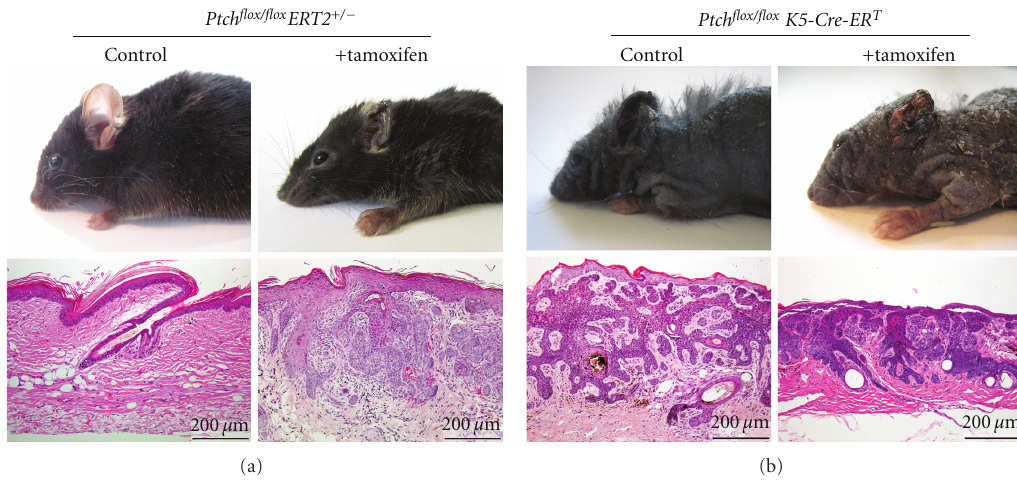
Figure 1: Features of BCC in Ptch flox/flox ERT 2 + / − and Ptch flox/flox K 5- Cre - ER T mice. Ptch flox/flox animals were bred with the mouse lines ERT2 or K 5- Cre - ER T . The respective Ptch flox/ + ERT 2 + / − and Ptch flox/ + K 5- Cre - ER T mice were backcrossed to Ptch flox/flox mice to obtain Ptch flox/flox ERT 2 + / − and Ptch flox/flox K 5- Cre - ER T mice. ERT2 or K 5- Cre - ER T was activated by one intramuscular (i.m.) injection of 100 μ g tamoxifen as described recently [20, 85], or by intraperitoneal injections of 1 mg tamoxifen (10 μ g/ μ L in sterile ethanol/sun flower oil 1: 25) for 5 consecutive days (see [88]), respectively. Genotyping of the Ptch flox , Ptch del , ERT2, and K 5- Cre - ER T alleles was performed as described recently [20, 84, 85]. All mice used in the study were handled in accordance with the German animal protection law. (a) shows the appearance and histology of skin from control and tamoxifen-treated Ptch flox/flox ERT 2 + / − mice and (b) shows that of control and tamoxifen-treated Ptch flox/flox K 5- Cre - ER T